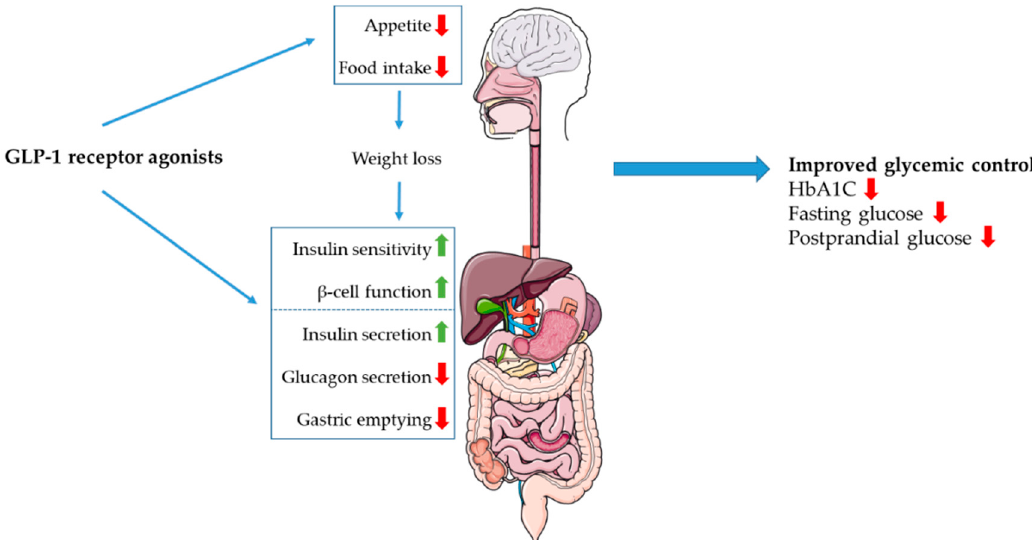
Figure 2. The central and peripheral e ff ects of GLP-1 receptor agonists are shown in this diagram. GLP-1 receptor agonists have shown to reduce food intake and appetite in various degrees. This results in weight loss, which enhances the positive e ff ects of GLP-1 receptor agonists on insulin sensitivity and β -cell function. Furthermore, administration of GLP-1 receptor agonists enhances insulin secretion, whilst inhibiting glucagon secretion and gastric emptying. This results in improved glycemic control in treated patients, as indicated by reduced Hemoglobin A1C (HbA1C) and fasting glucose